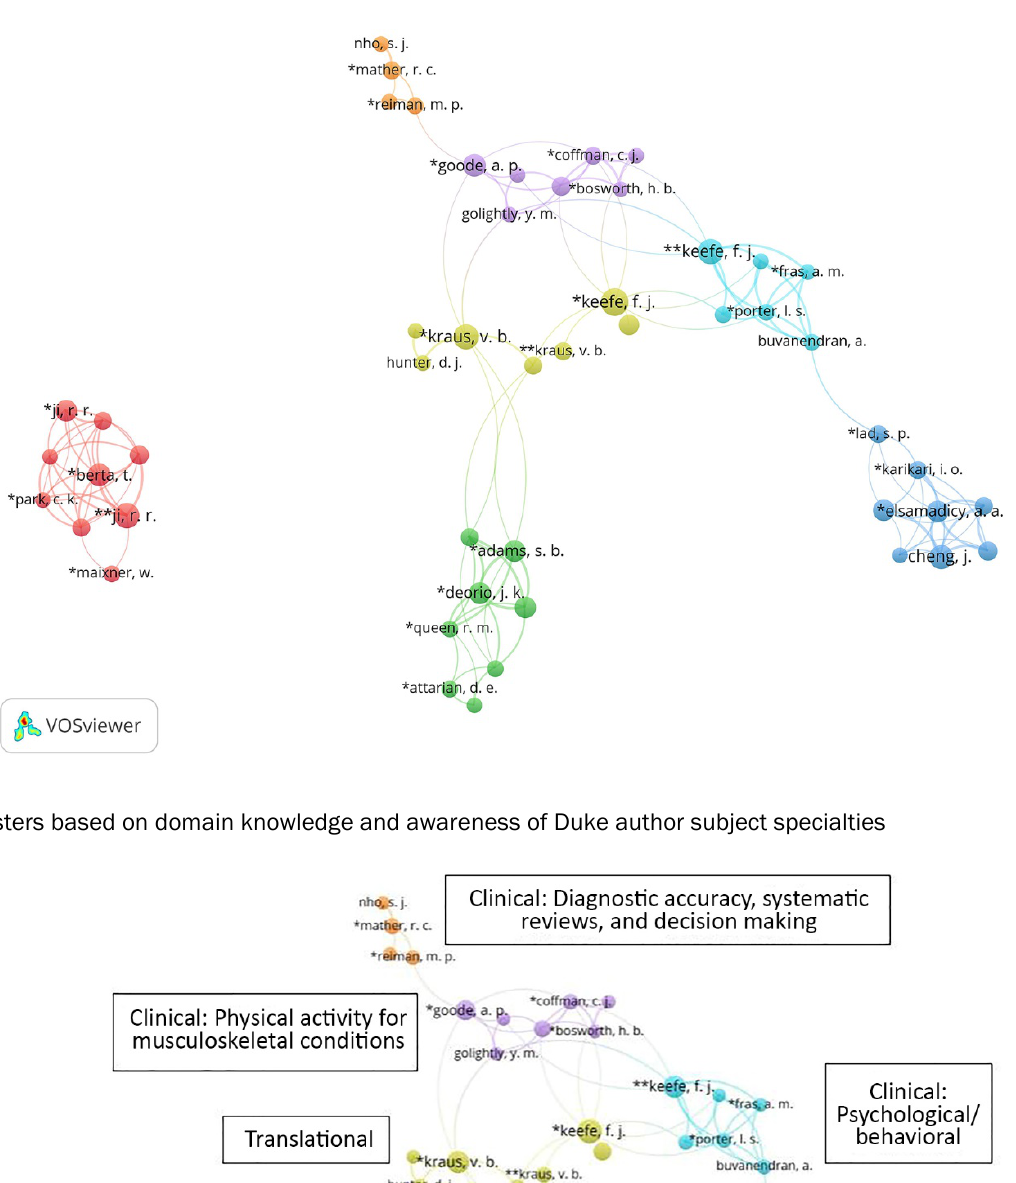
Figure 2 Visualized coauthorship network